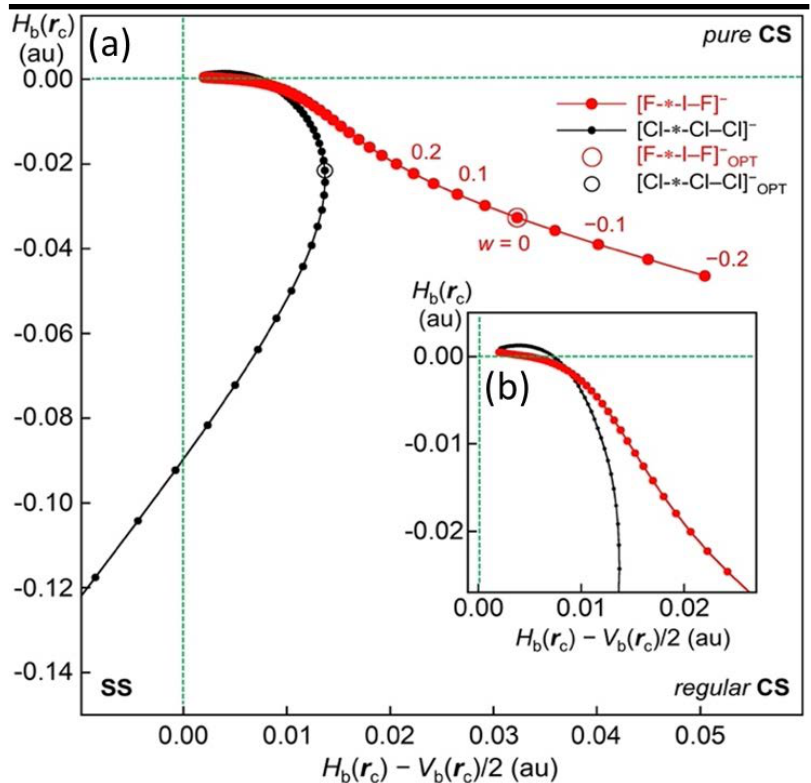
Figure 9. Plots of H b ( r c ) versus H b ( r c ) − V b ( r c )/2 for the wide range of interaction distances for [F–I- ∗ -F] − (shown by a larger red dot with w = 0.0 for the fully optimized structure) under MP2/BSS- C with the plot for [Cl–Cl- ∗ -Cl] − , shown by a dotted line, as a reference ( a ). A magnified picture around the origin is also shown ( b ). The perturbed structures are generated with